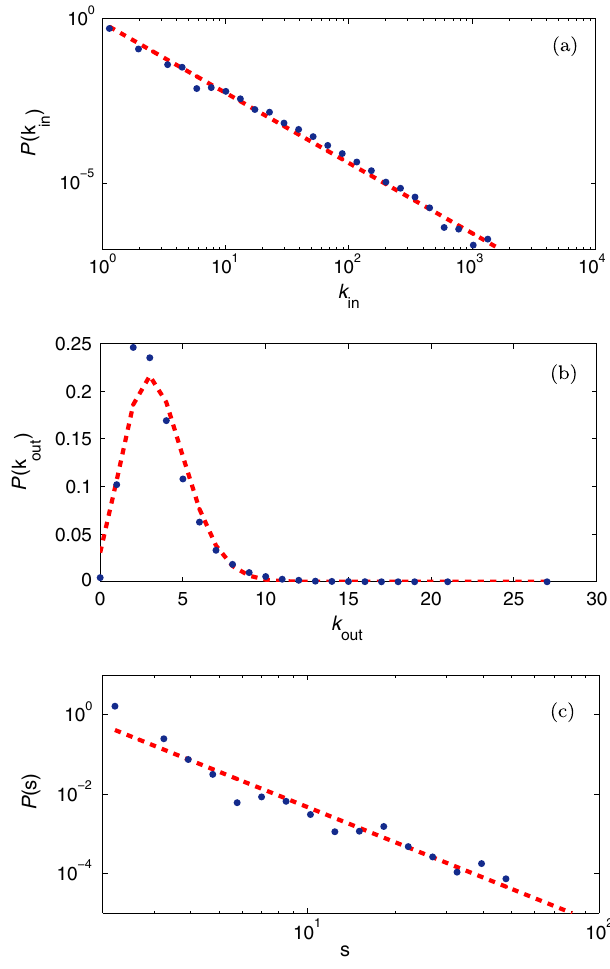
FIG. 7. Extraction of model parameters. Probability distribu- tions were measured for (a) in-degree, (b) out-degree, and (c) strongly connected component sizes for the empirical dictionary graph. The dashed lines in (a) and (c) have slopes 2.1 and 2.9, respectively, while the Poisson fit in (b) has parameter 3.5. In the model, these statistics correspond to a new word attractiveness a ¼ 0 : 4 and a probability of new SCC formation p ¼ 0 : 4